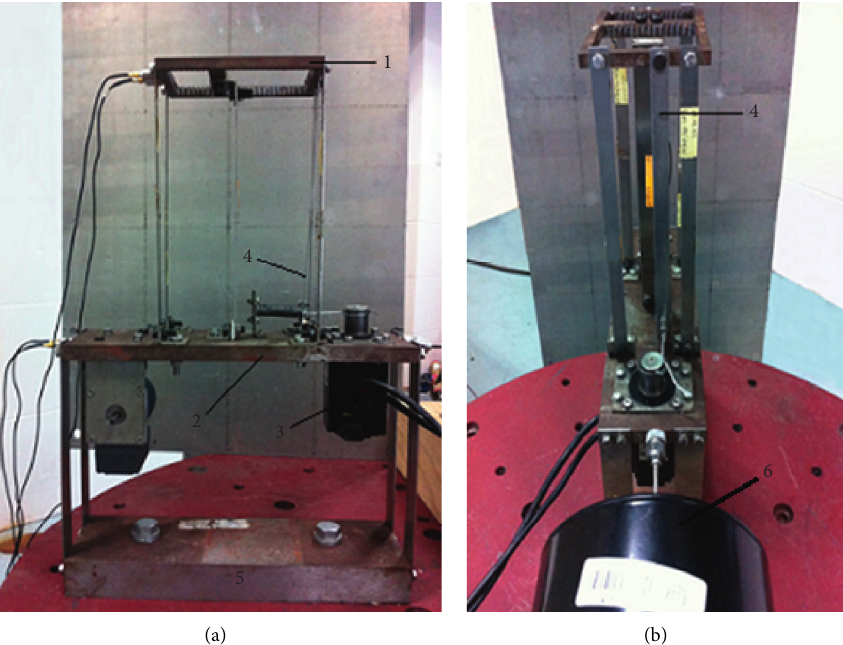
Figure 2: Photo of experiment setup: (a) front view; (b) right view (1: absorber mass, 2: primary mass, 3: servo motor, 4: controlled steel sheet, 5: base, and 6: shaker).